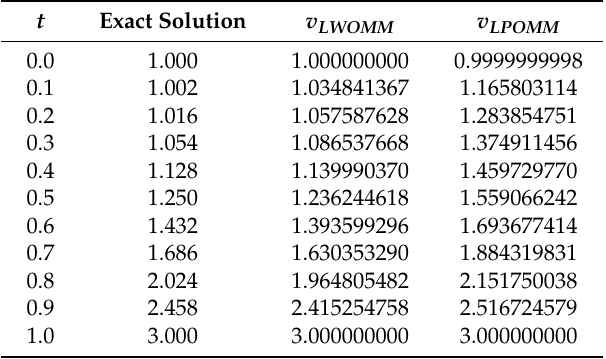
Table 4. The numerical results attained by using the introduced method in comparison with the approximate solution LPOMM and exact solution v ( t ) in Example